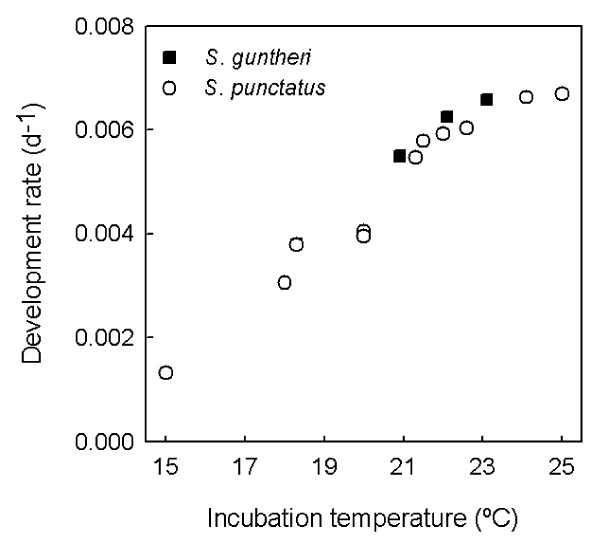
Relationship between development rate and constant incubation temperature in two Sphenodon species from Cook Strait. Development rate declines at the hottest incubation treatments attempted for S. punctatus, suggesting that the maximum constant temperature tolerated may be only 1–2°C higher.